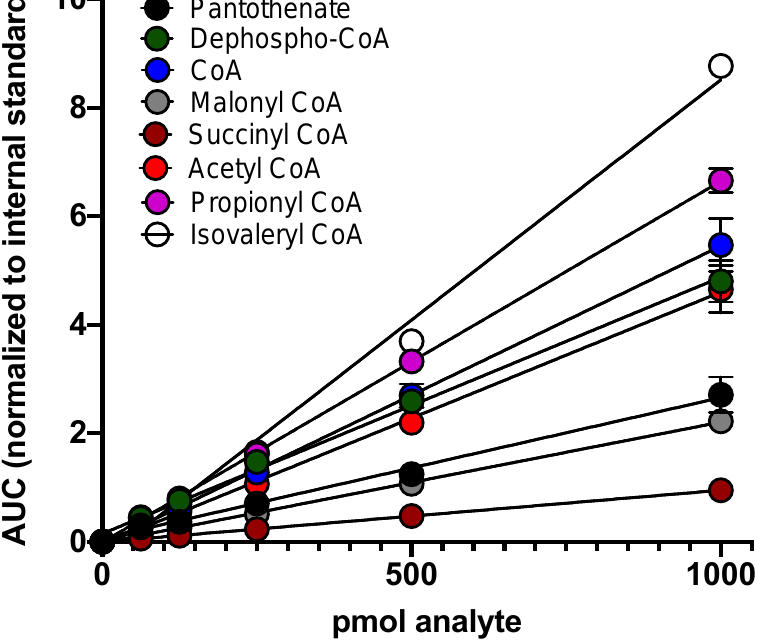
Figure 4. The LC-MS/MS method demonstrates a linear detection of analytes across a wide concentration range: standards were spiked into 200 µ L of extraction solution and analyzed via LC-MS/MS. Calibration curves were generated by plotting the area under the curve (AUC) for each analyte (normalized to the internal standard) against the amount of analyte contained in 200 µ L of extraction solution. Data are presented as mean ± standard error of the mean (S.E.M.) for n ≥ 3 technical replicates.